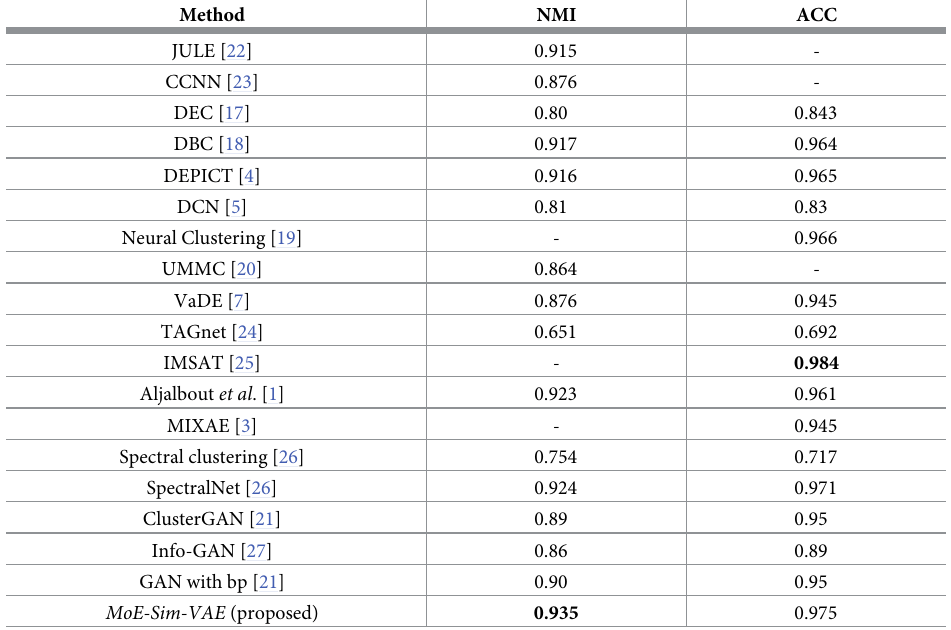
Table 1. Performance comparison of our method MoE-Sim-VAE with several published methods on MNIST. The table is mainly extracted from [1, 21] and complemented with results of interest. (“-”: metric not